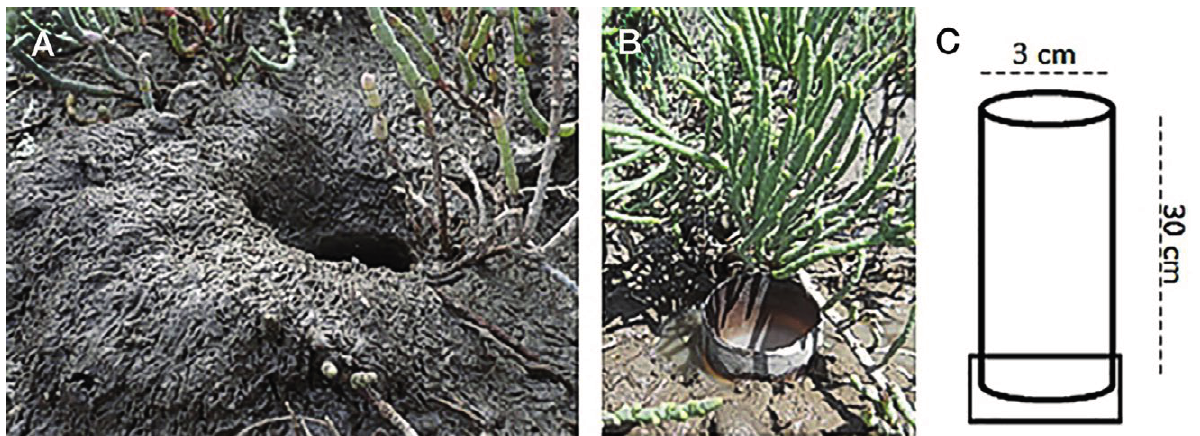
Fig. 2. – Tubular burrows of Neohelice granulata. A, burrow in saltmarsh; B, mock burrow with PVC pipe (the elevation of the mock burrow was only for the purpose of display, after the photograph the pipe was inserted at intertidal level); C, diagram of burrow